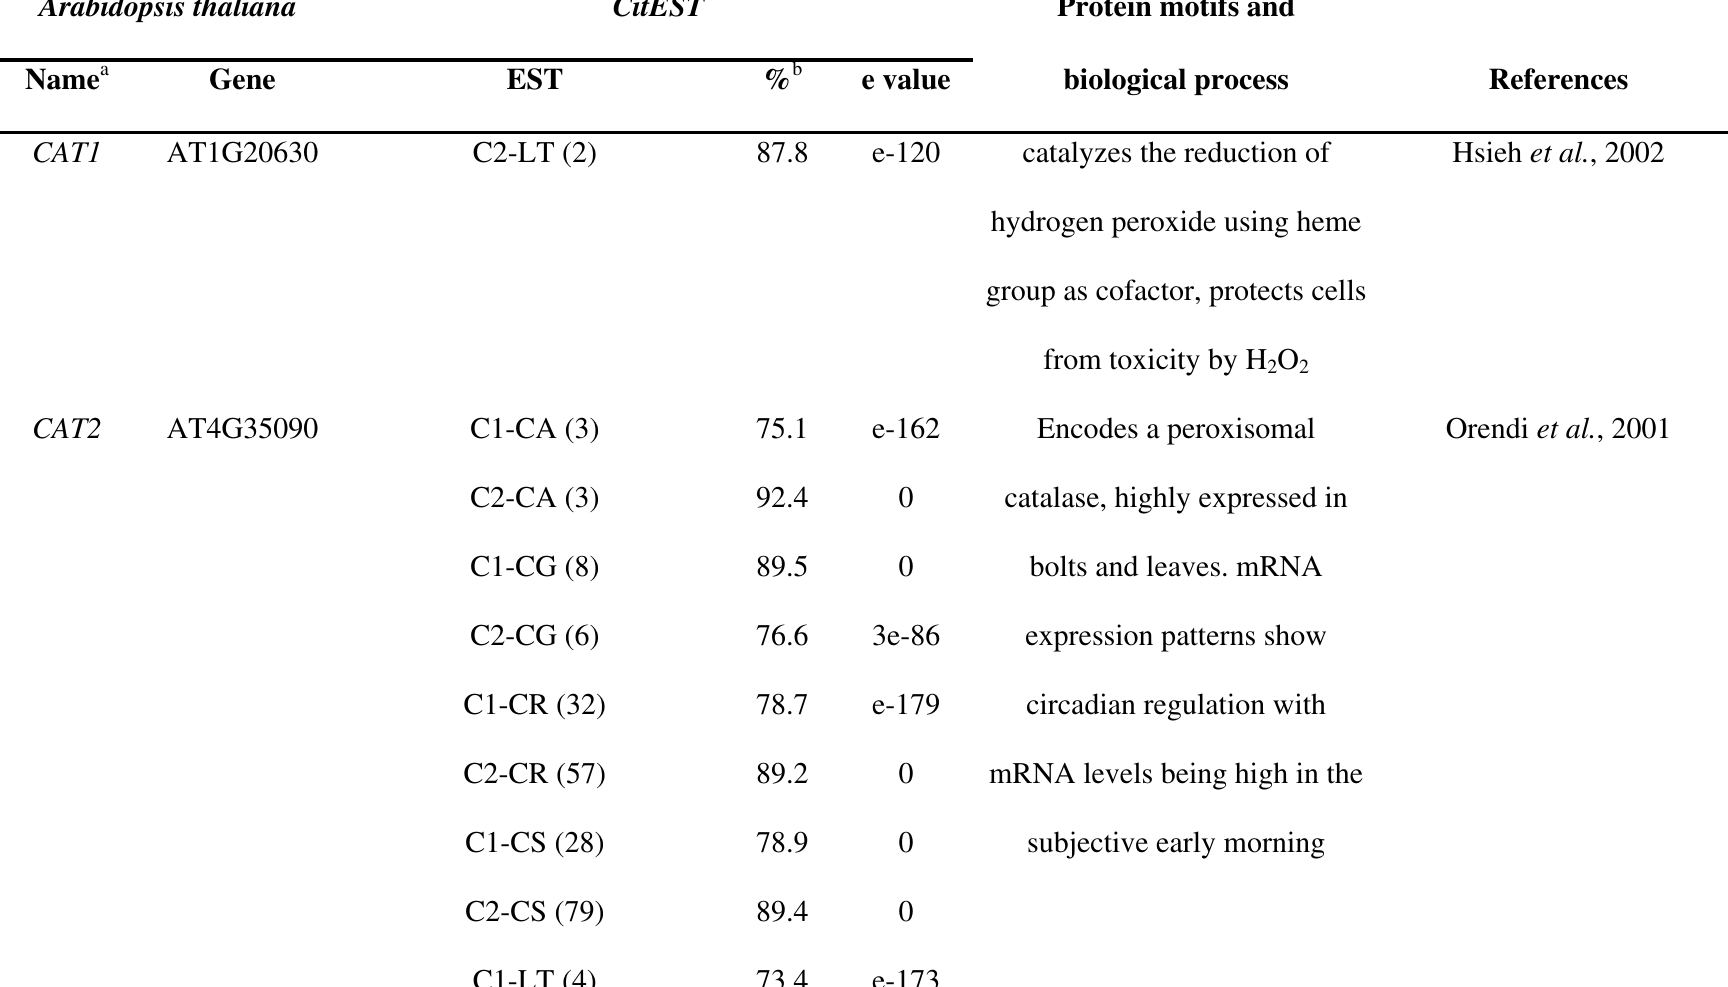
Table S11 – Citrus ESTs with homology to catalase protein families from Arabidopsis thaliana